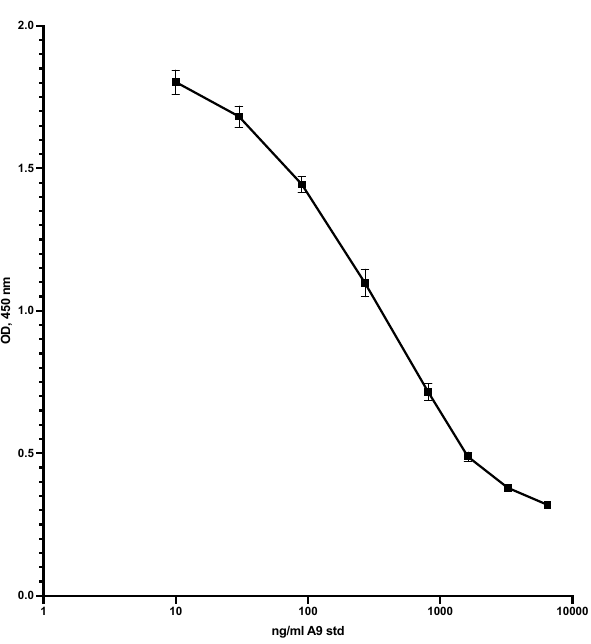
Figure 2. Typical standard curve for the FELISA. A total of 50 µL standard and samples diluted in TBS with 5 mM EDTA was added to the wells and shaken at RT for 20 min. After washing, HRP anti-MiMo diluted 1:80 000 in assay buffer was added, and plates were shaken at RT for 30 min. After washing again, 100 microliters of tetramethylbenzidine were added and the plate read after 40 min. The FELISA has an assay range between 20 and 2000 ng/mL and a mean CV for standards of about 1.2% when they are dissolved in TBS with 5 mM EDTA. J. Mol. Pathol. 2022 , 3 , FOR PEER REVIEW Figure 3 shows the standard curve for the competitive S100A9 ELISA. The assay range was 10 to 5000 ng/mL, and the CV between 0.5 and 9.2 per cent.